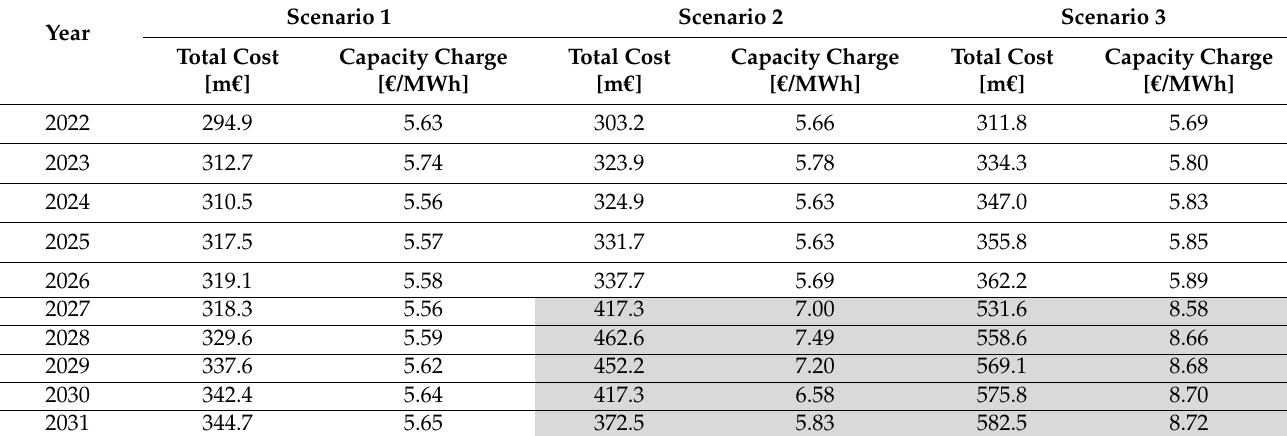
Table 5. CRM Cost–Aggressive